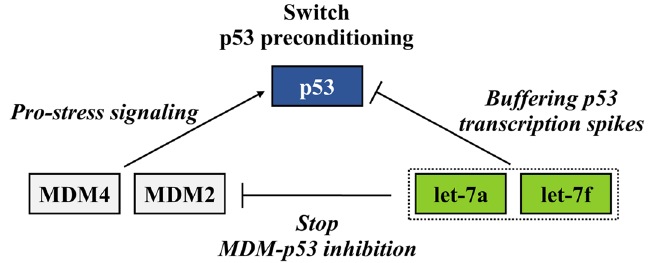
Figure 8. Tp53 preconditioning. The figure shows the hypothetical functional state of transient tolerance to SAR stress allowed by p53 preconditioning. The figure is created by G. Guelfi using PowerPoint 2021, Microsoft Corporation,